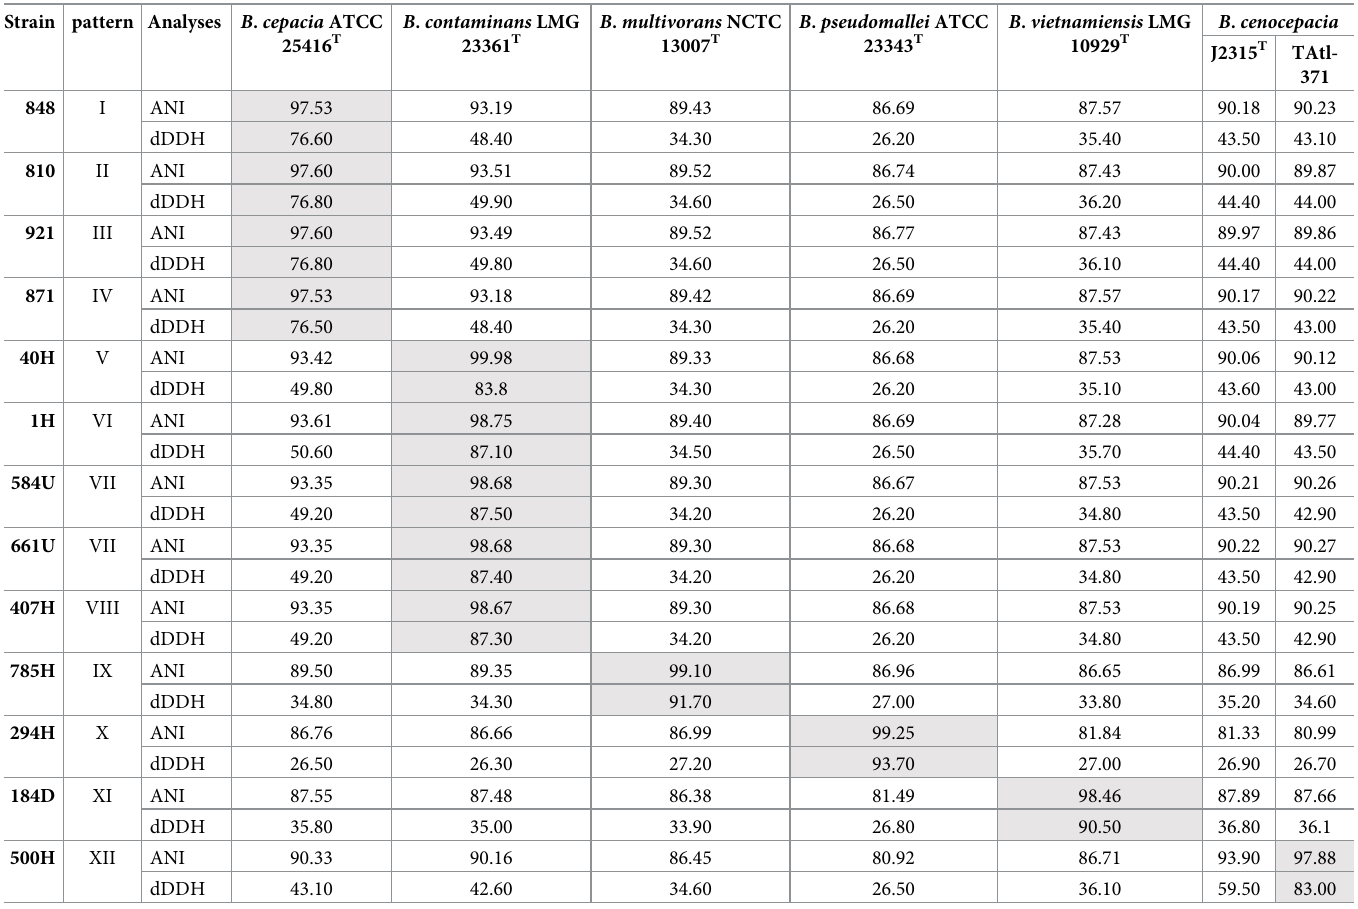
Table 2. Identification of Burkholderia strains by genome analyses. Strain pattern Analyses B . cepacia ATCC 25416